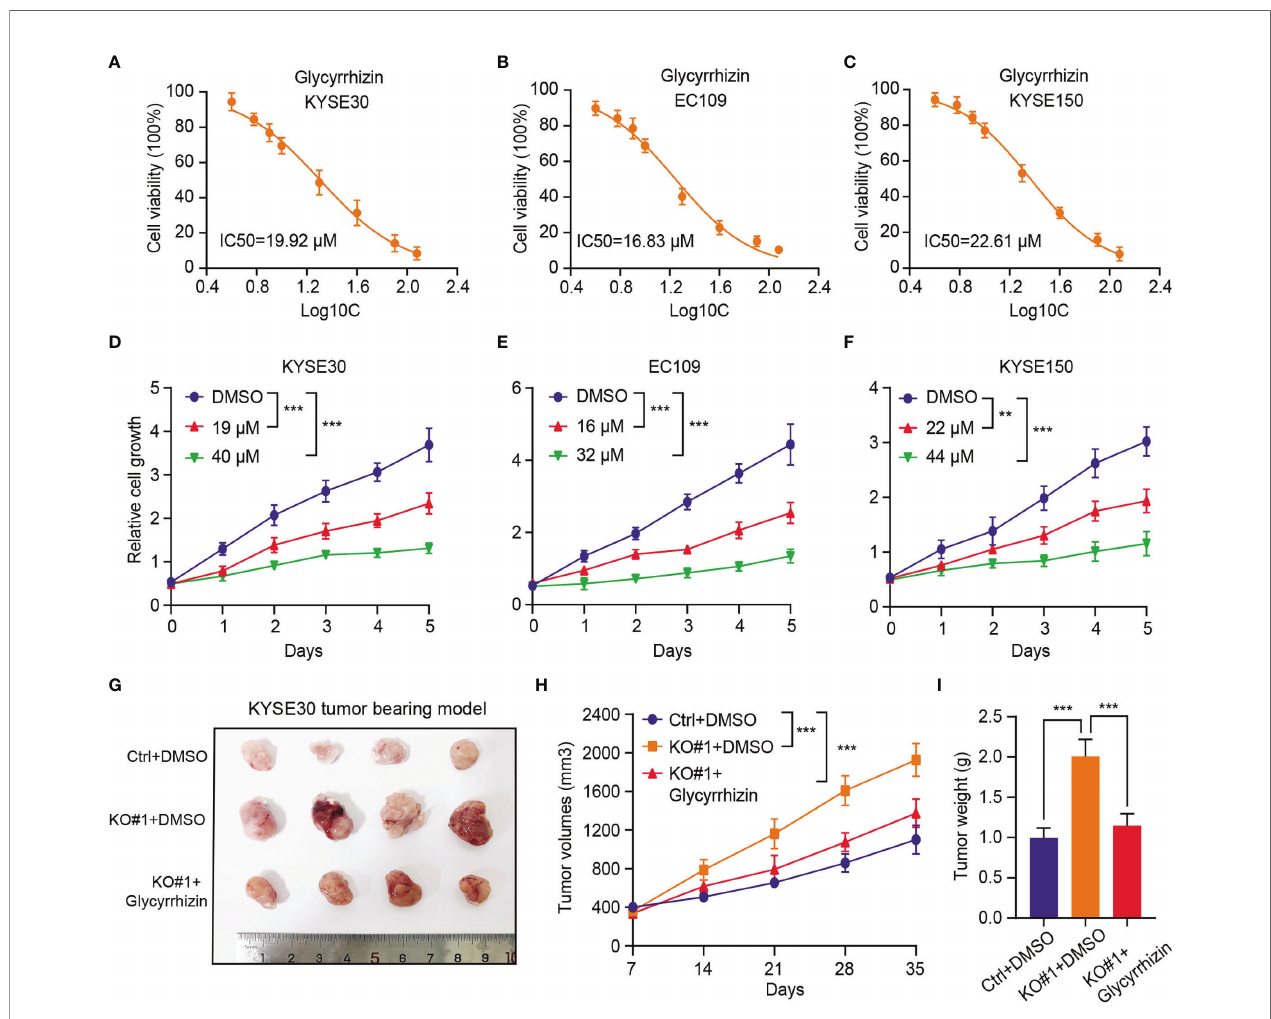
FIGURE 6 | HMGB1 inhibitor (Glycyrrhizin) notably suppresses in vitro and in vivo tumor growth of KMD4D low ESCC. (A-C) Detection of the half maximal inhibitory concentration (IC50) values of Glycyrrhizin in three ESCC cell lines (KYSE30, EC109 and KYSE150). (D-F) The cell growth ability of the ESCC cells (KYSE30, EC109 and KYSE150) were all remarkably impaired with Glycyrrhizin treatment in a dose ‐ dependent manner. (G) HMGB1 inhibition (Glycyrrhizin) effectively suppressed ESCC subcutaneous tumour growth in nude mice (n = 5). (H) The tumour volume was detected every other day, and tumour growth curves were generated. (I) The tumours were extracted and weighed after 35 days. * P < 0.05, ** P < 0.01, *** P <